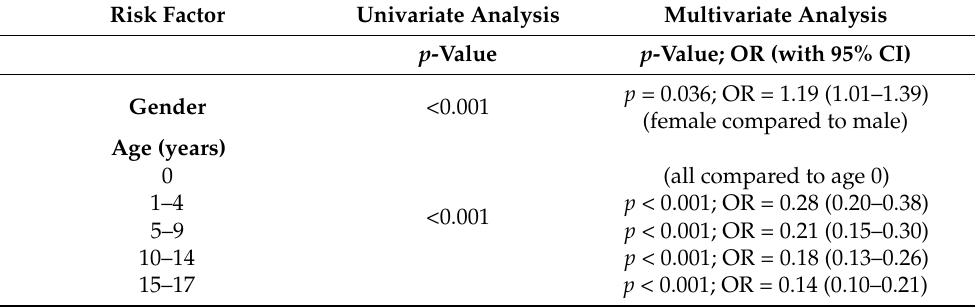
Table 2. Predictors for RBC